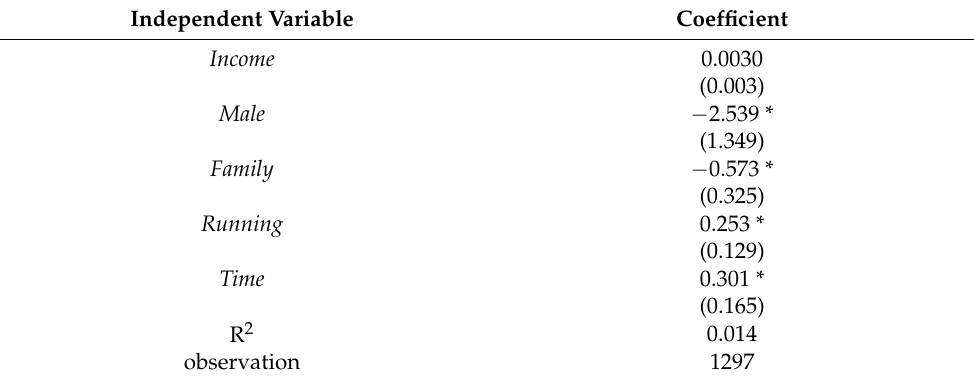
Table A2. Coefficient of linear parametric independent